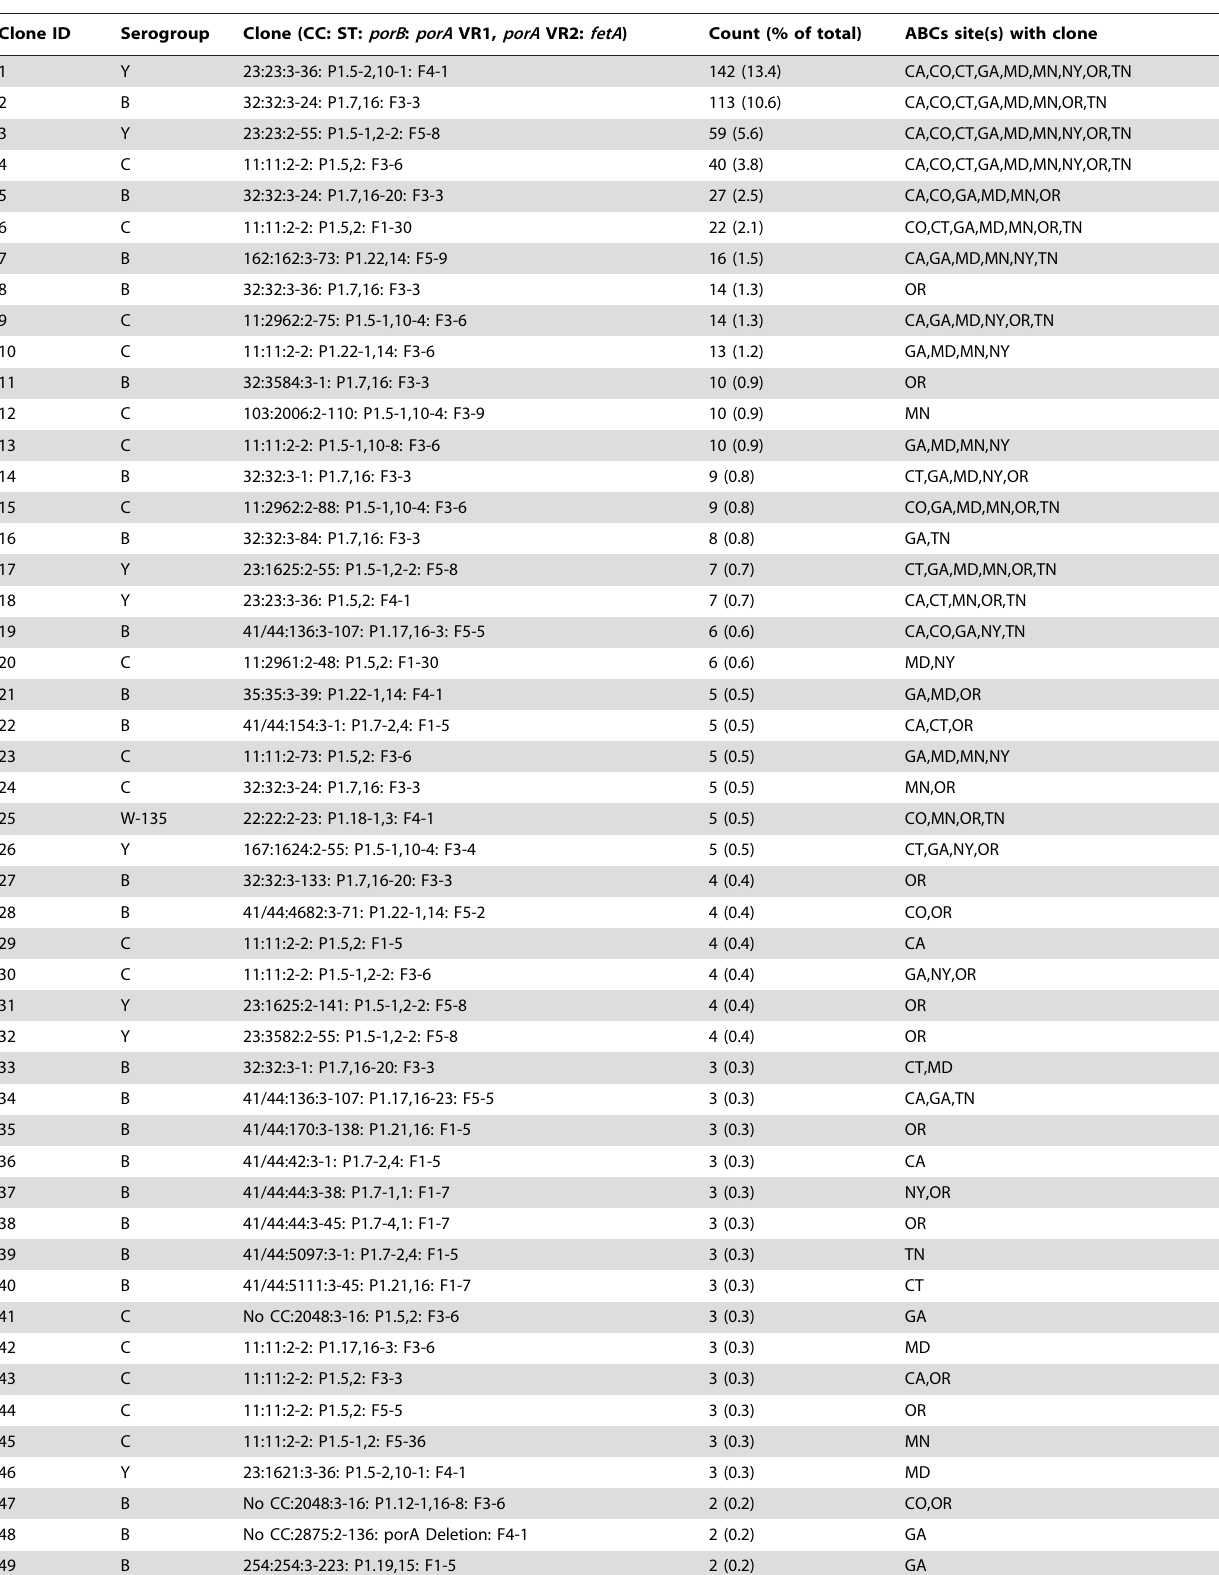
Table 1. Case counts of non-singleton meningococcal clones, ranked by decreasing frequency.